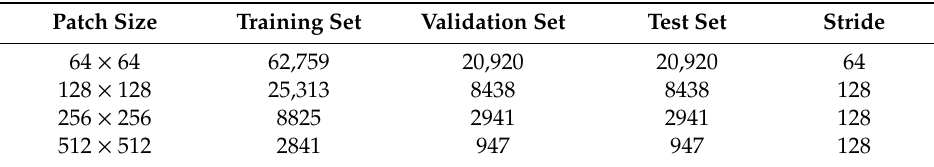
Table 2. Statistics for sample capacities and clip strides with all four patch